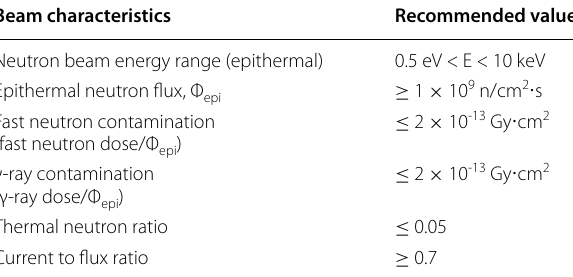
Table 1 Recommended neutron beam characteristics from IAEA TECDOC‑1223 Beam